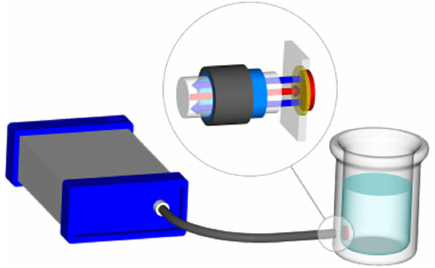
Figure 3. Schematic of pH monitoring system with EOM-pH-mini (left), and fibre optic conveying light to fluorescent spot attached to inside of vessel (right). The magnified circle shows light conveyed through the transparent vessel wall to the spot (red arrow), and flu- orescent light emitted from the spot back along the fibre (blue ar-